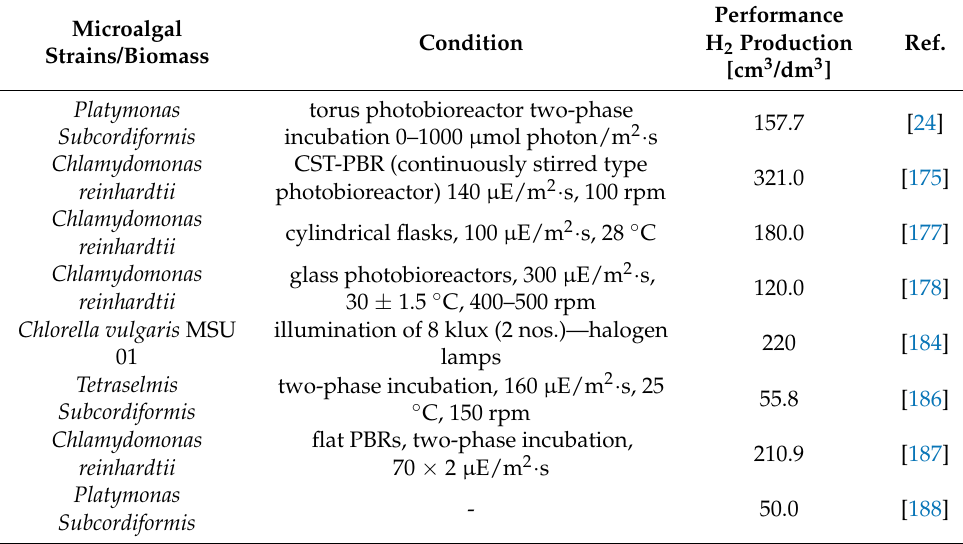
Table 3. Comparison of literature data on microalgal hydrogen productivity.